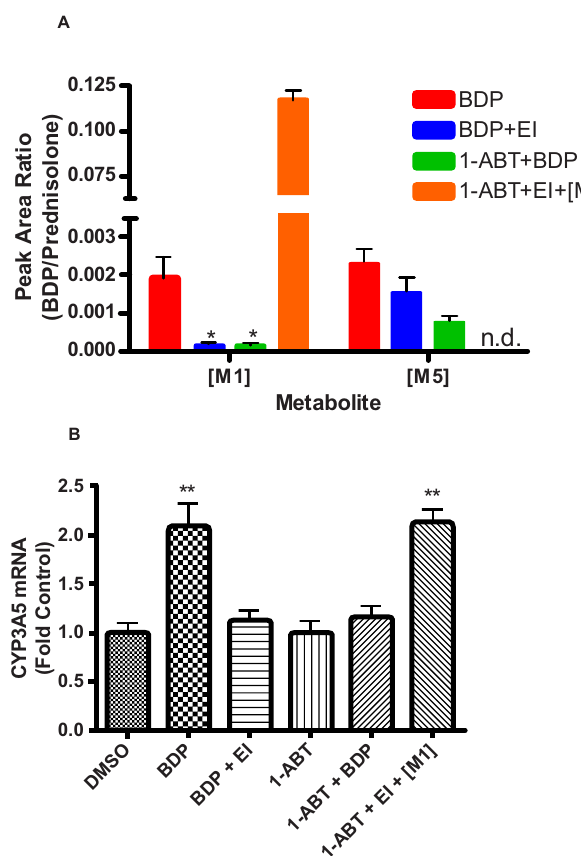
Figure 3. [M1] is required to induce CYP3A5 mRNA. ( A ) Relative quantities of [M1] and [M5] measured by LC/MS/MS in A549 cell culture media following beclomethasone dipropionate (BDP) treatment alone, BDP + esterase inhibitors (EI), 1-aminobenzotriazole (1-ABT) + BDP, and 1-ABT + EI + [M1]. ( B ) CYP3A5 mRNA detected in A549 cells following DMSO control, BDP treatment alone, BDP + EI, 1-ABT alone, 1-ABT + BDP, and 1-ABT + EI + [M1]. Values are expressed as fold over DMSO controls. Statistics used for data analysis were one-way ANOVA with Dunnett’s post-hoc test. Data are the mean and standard deviation from n=6 replicates. * p<0.05, ** p<0.01. Table 2. Comparison of glucocorticoid receptor (GR), constitutive androstane receptor (CAR), and CYP3A5 mRNA expression in lung cell cultures. Cell type